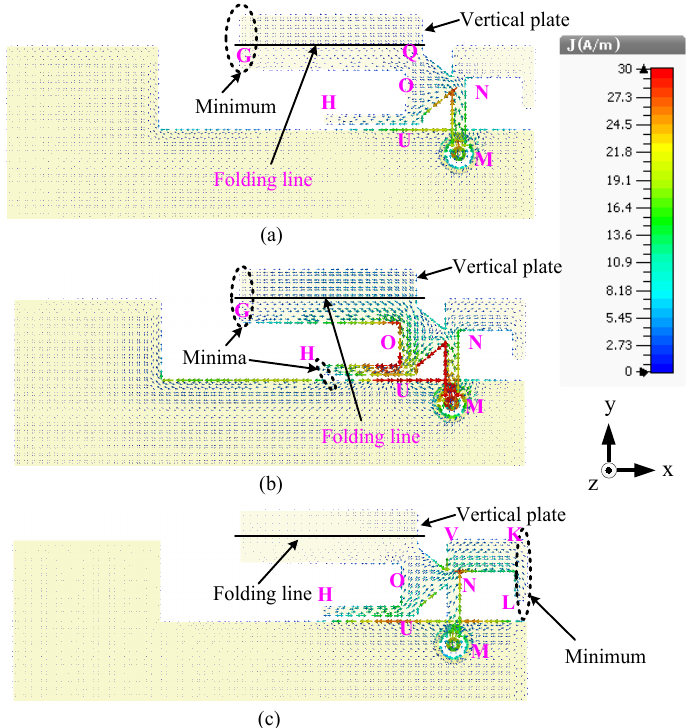
Figure 9. Surface current distributions of the dual-band antenna (Ant#2) at ( a ) 1.8, ( b ) 2.6, and ( c ) 3.6